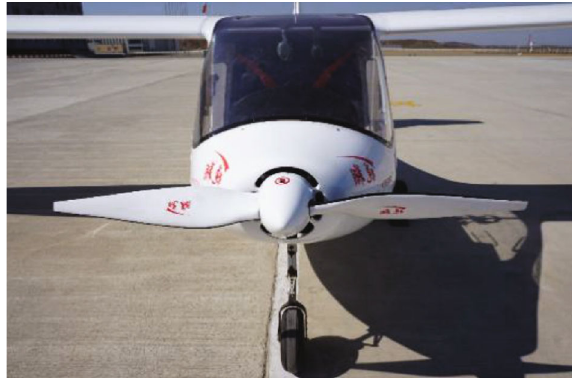
Figure 8: Propeller